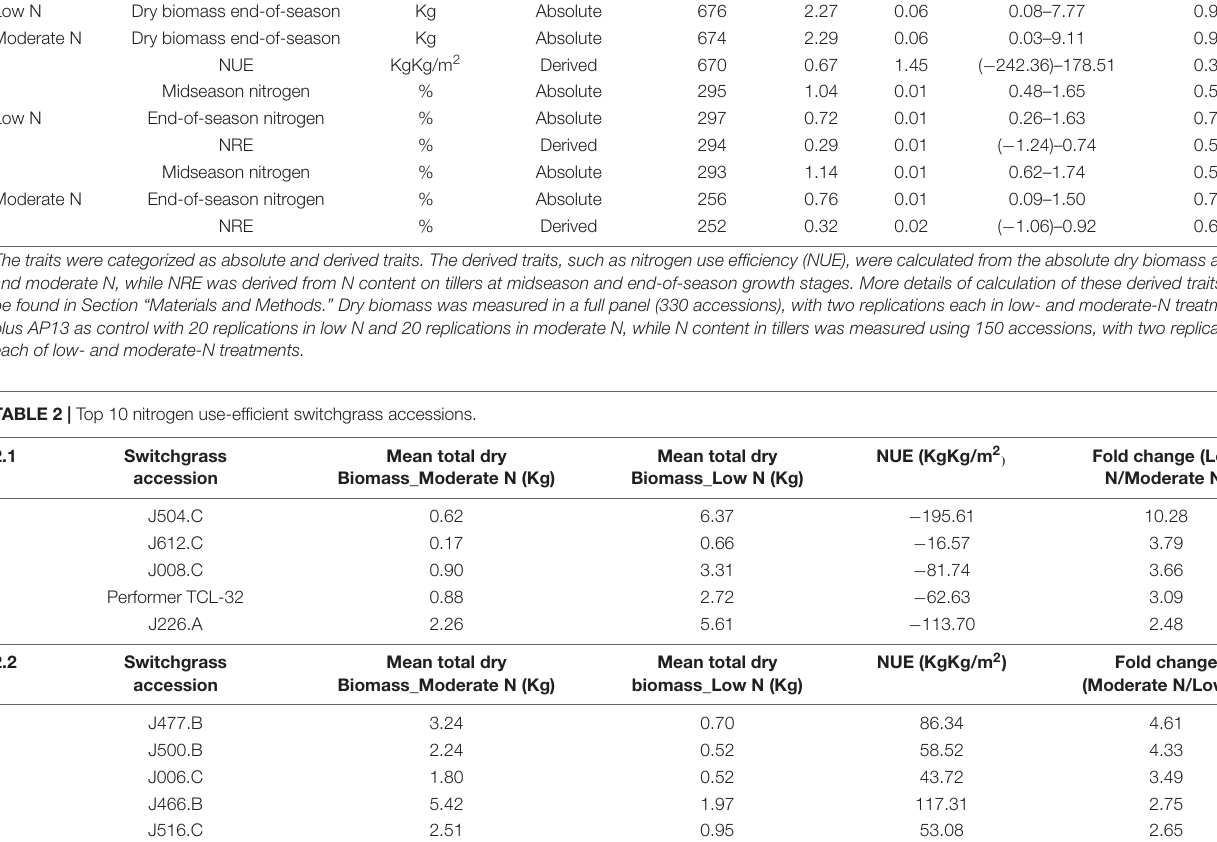
TABLE 1 | A descriptive statistical summary [mean, standard error (SE), and range] of NUE and related traits and their estimated heritability at low- and moderate-N conditions on a switchgrass diversity panel. Treatment